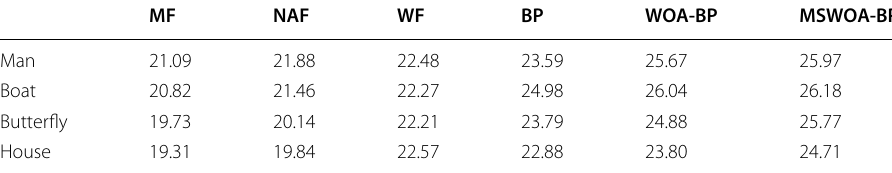
Table 6 PSNR with different denoising algorithms for benchmark images